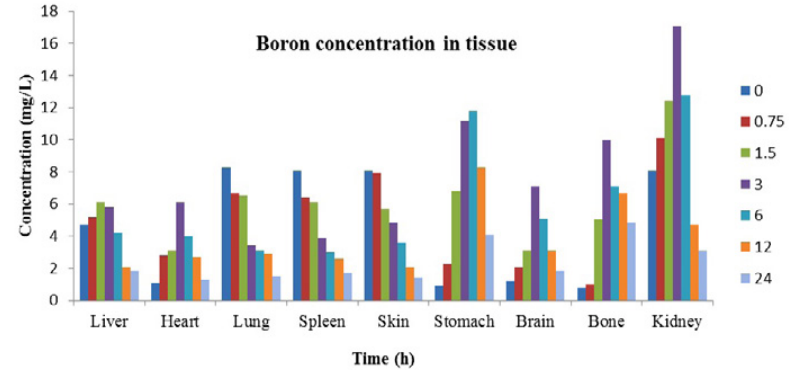
Fig. 11. Boron concentration in several tissue samples for the drug with respect to time